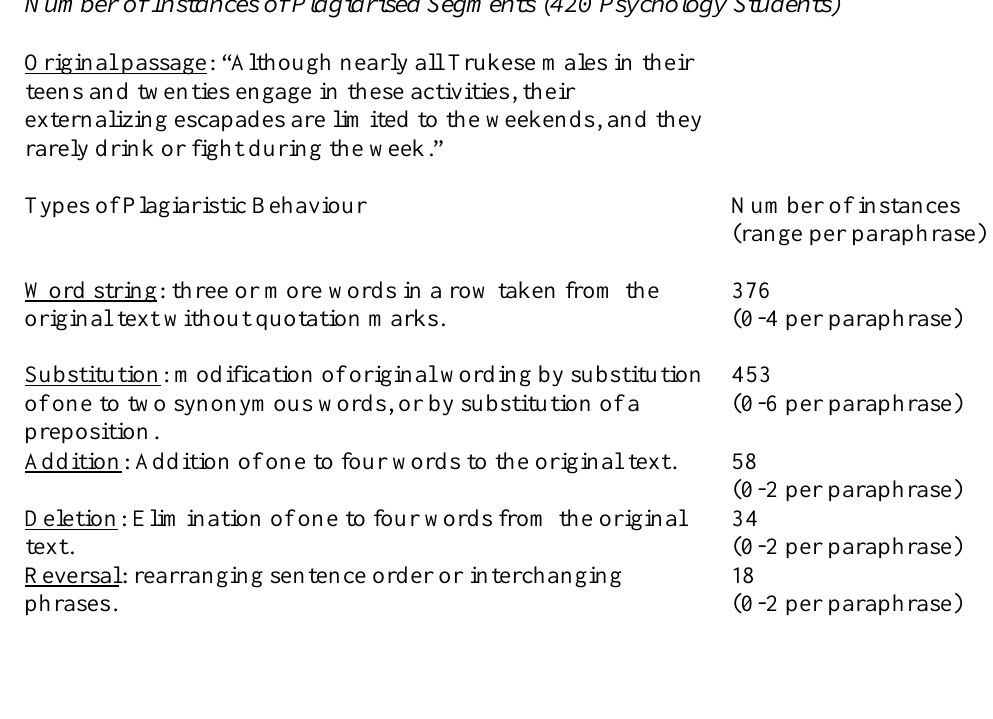
Number of Instances of Plagiarised Segments (420 Psychology